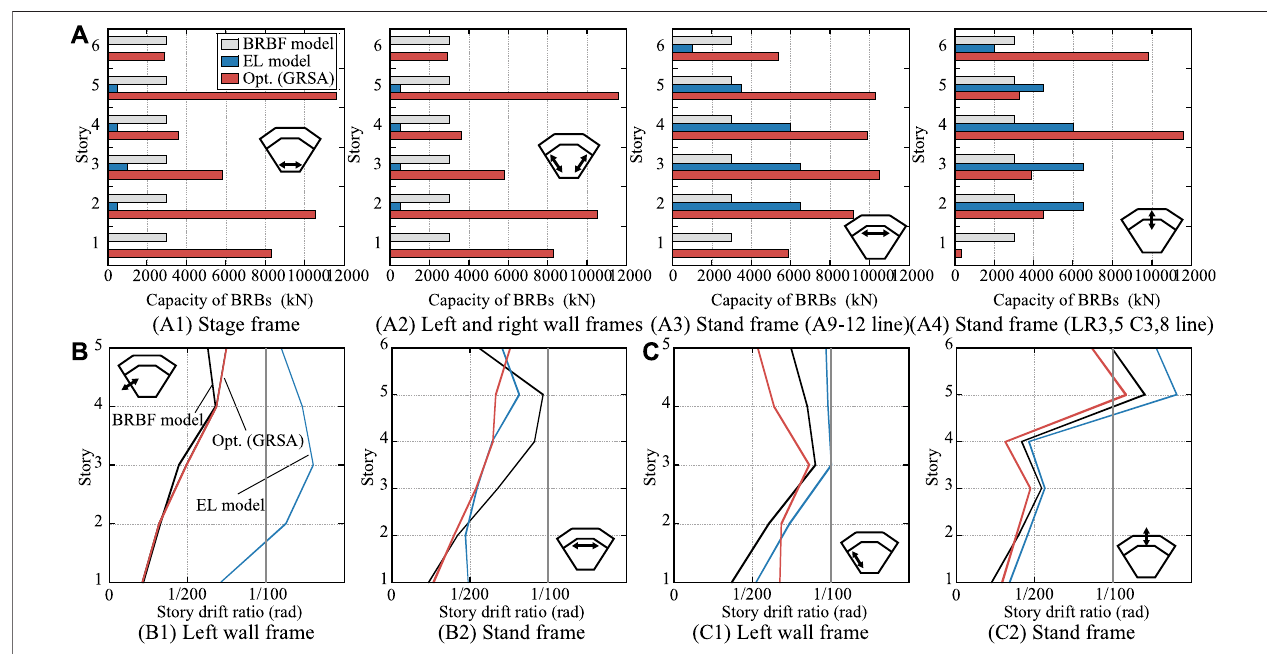
FIGURE 5 | Comparisons of the EL method and the GRSA-based seismic optimization: (A) Capacity distribution of BRBs, (B) Maximum story drift ratio (X-directional input), (C) (A) Maximum story drift ratio (Y-directional input).